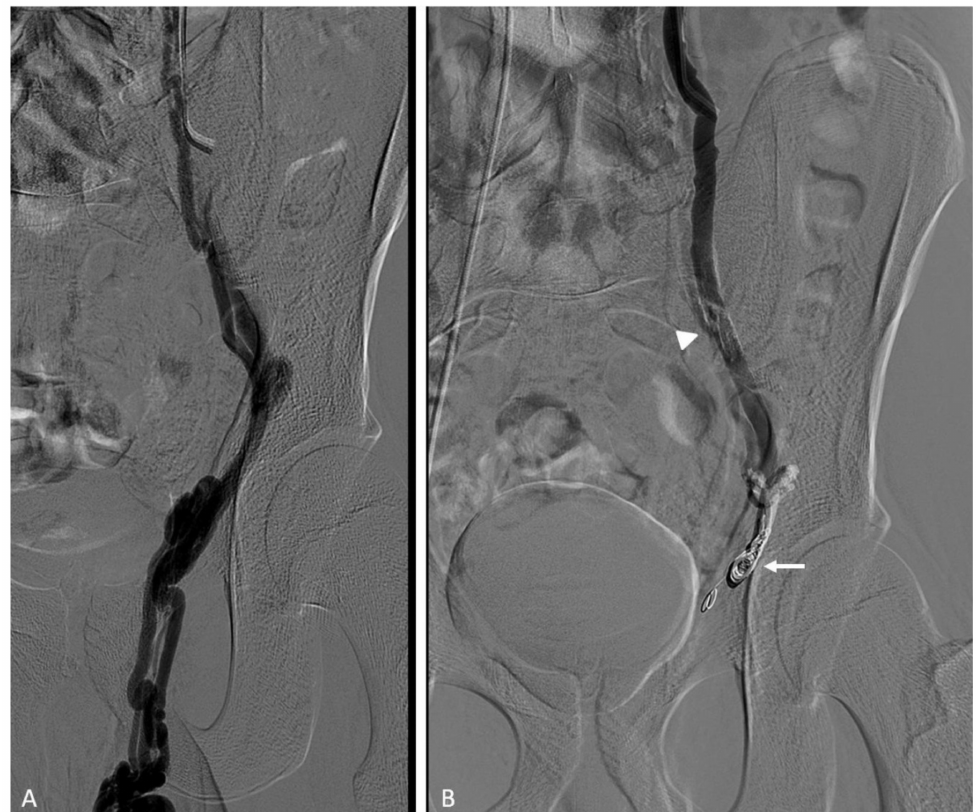
Figure 12. Transcatheter coil and glue embolization of recurrent varicocele after surgery in a 16-year-old male. ( A ) Selective left spermatic vein venography image shows an enlarged and refluent left spermatic vein with duplication and retrograde opacification of the pampiniform plexus. ( B ) Post- embolization venography image proves absence of opacification of the pampiniform plexus after distal occlusion with coils (arrow) and glue that spread into a duplicated vein